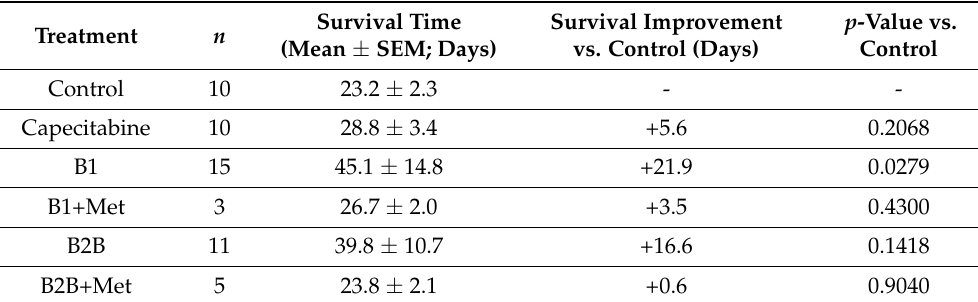
Table 4. Survival of mice with metastatic colon cancer (peritoneal dissemination model) treated with capecitabine and several artificial